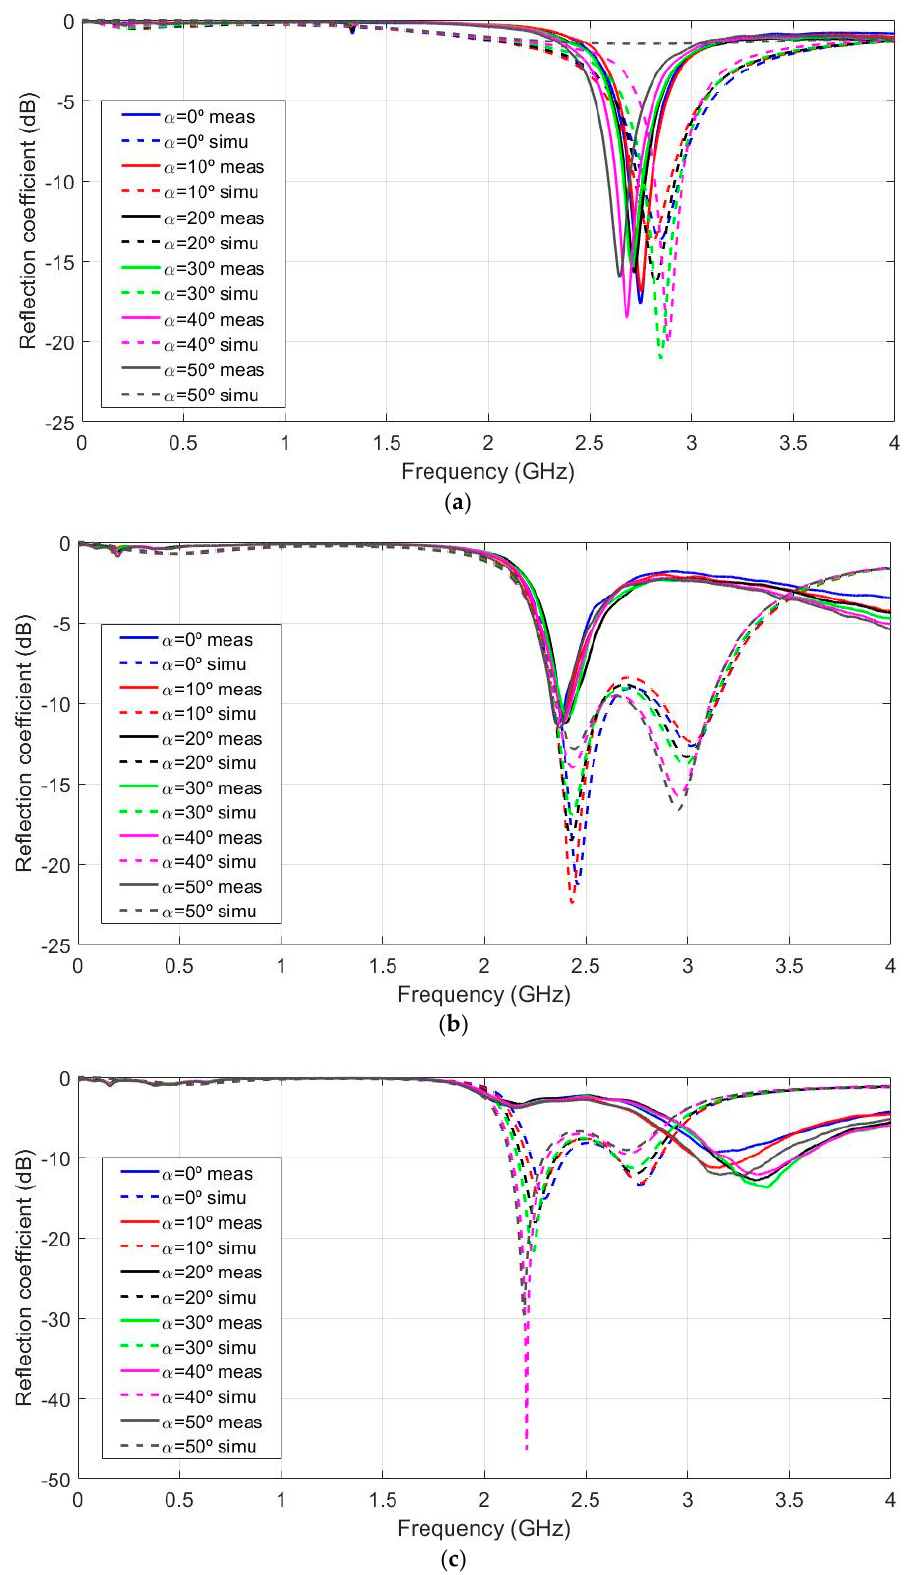
Figure 11. Comparison of the reflection coefficient measured and simulated with different values for the